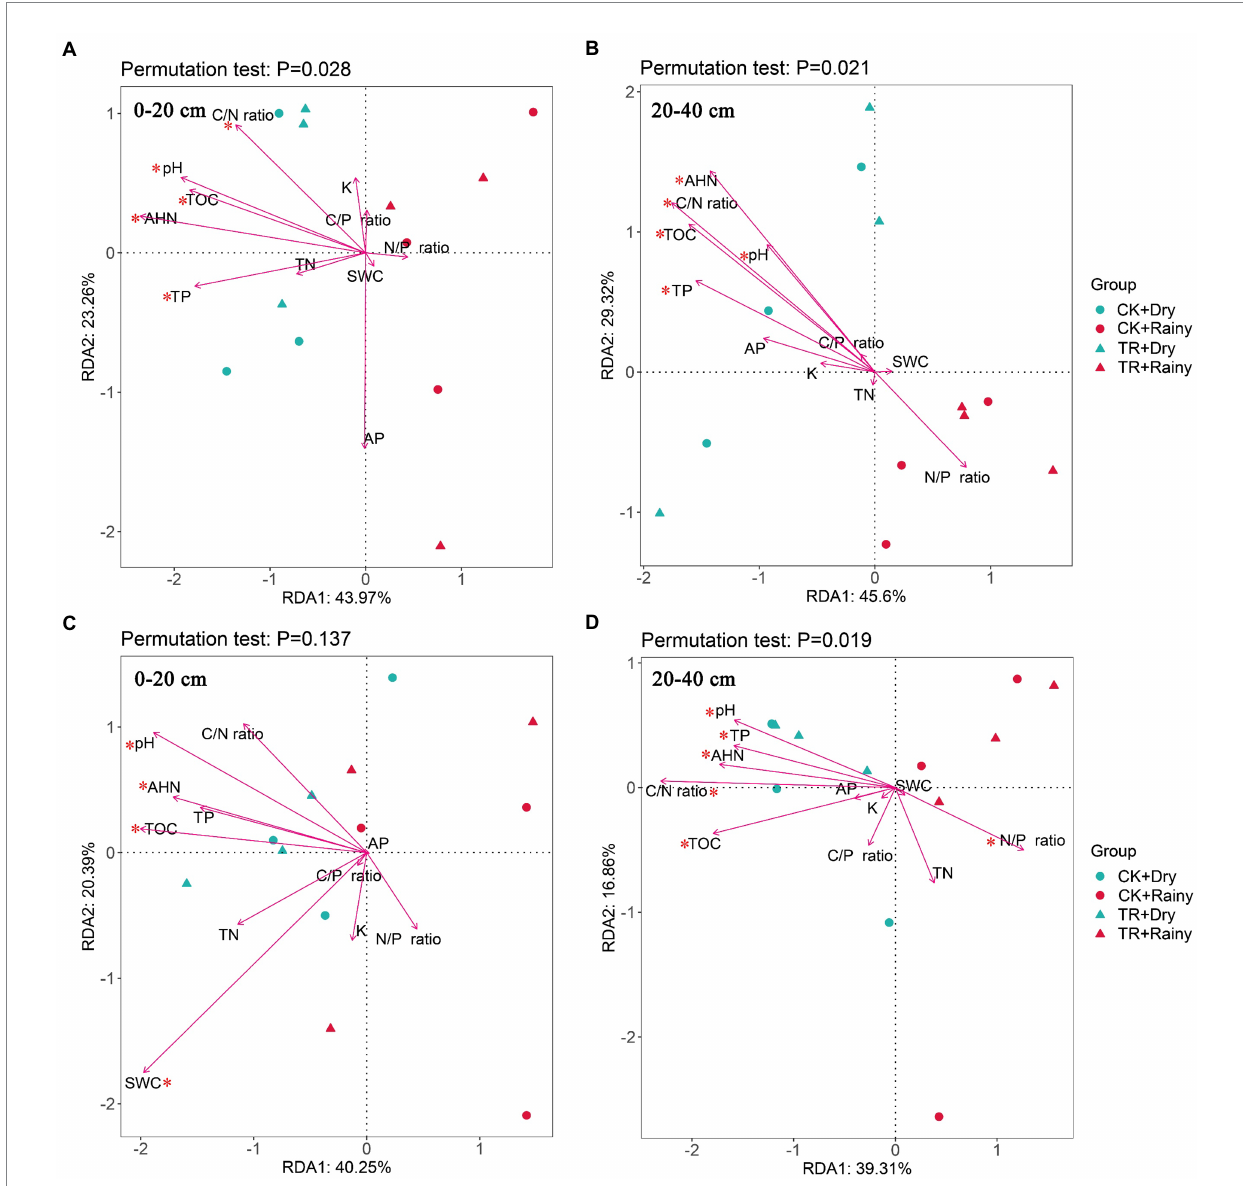
FIGURE 4 Redundancy analysis (RDA) illustrating the relationships between bacterial (A,B) or fungal (C,D) communities and soil physicochemical properties. TN, total nitrogen. TP, total phosphorus; TK, total potassium; TOC, total organic carbon; AP, available phosphorus; SWC, soil water content; AHN, alkali hydrolyzed nitrogen; C/N ratio, the ratio of total organic carbon and total nitrogen; C/P ratio, the ratio of total organic carbon and total phosphorus; N/P ratio, the ratio of total nitrogen and total phosphorus. p -values represent the result of PERMANOVA testing with 999